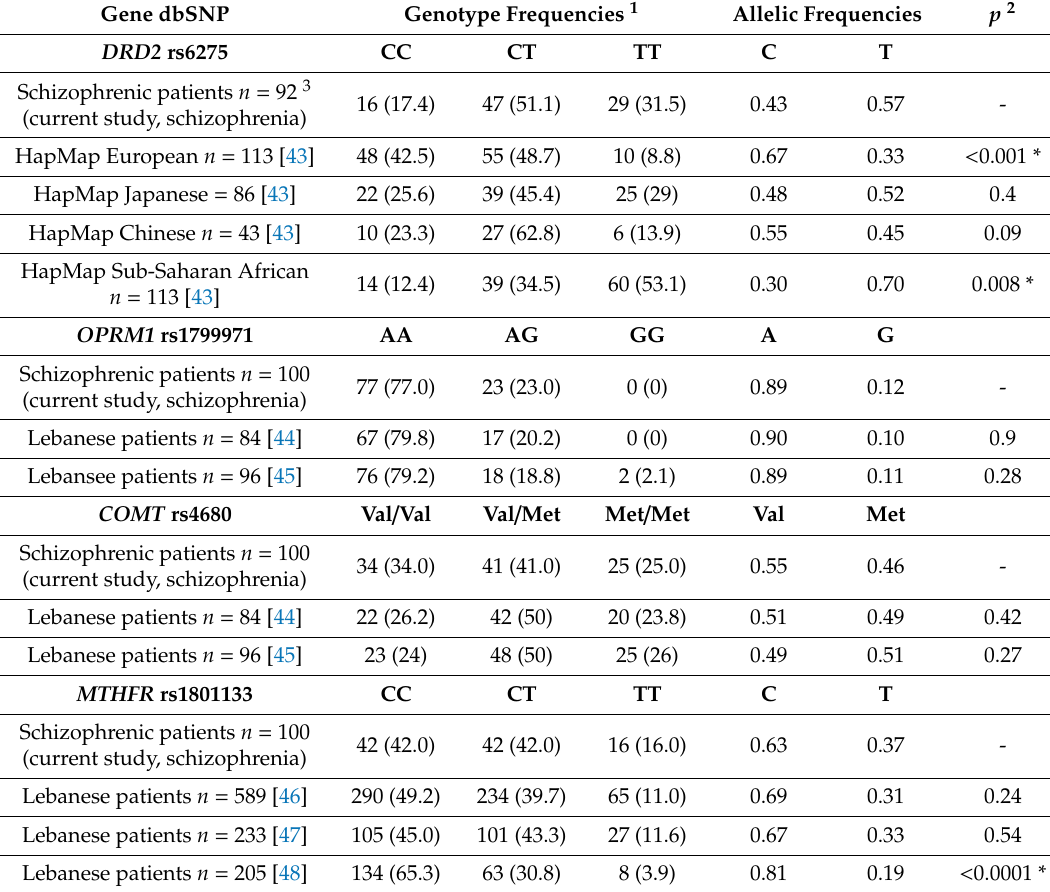
Table 2. Genotype and allele frequencies of DRD2, OPRM1 , COMT and MTHFR variants in our population with a comparison with other previously published